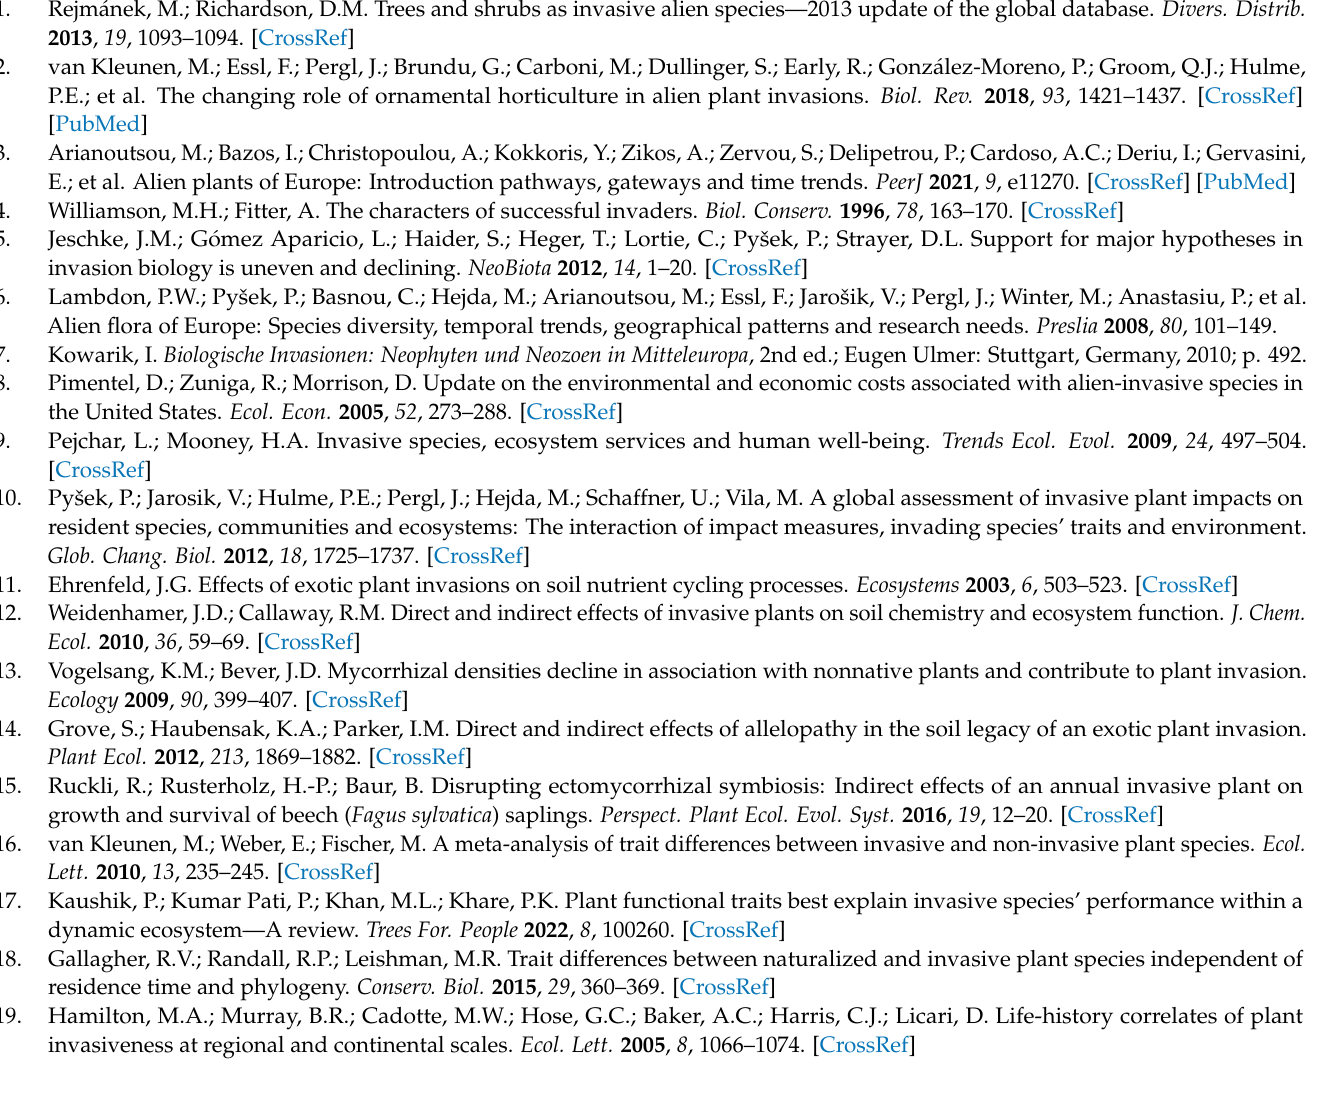
number of different substrates used following Zak et al.